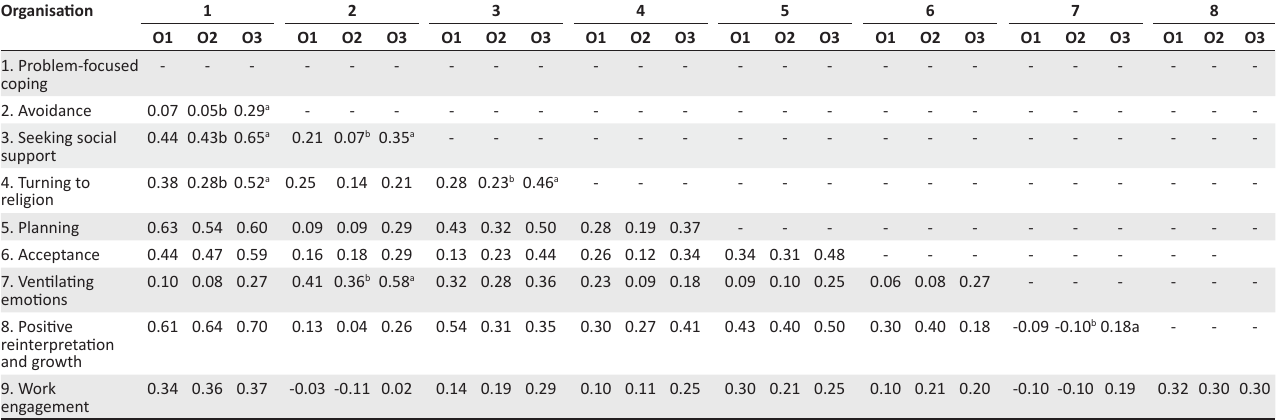
TABLE 5: Comparison of the correlations between coping and work engagement in three occupational groups.